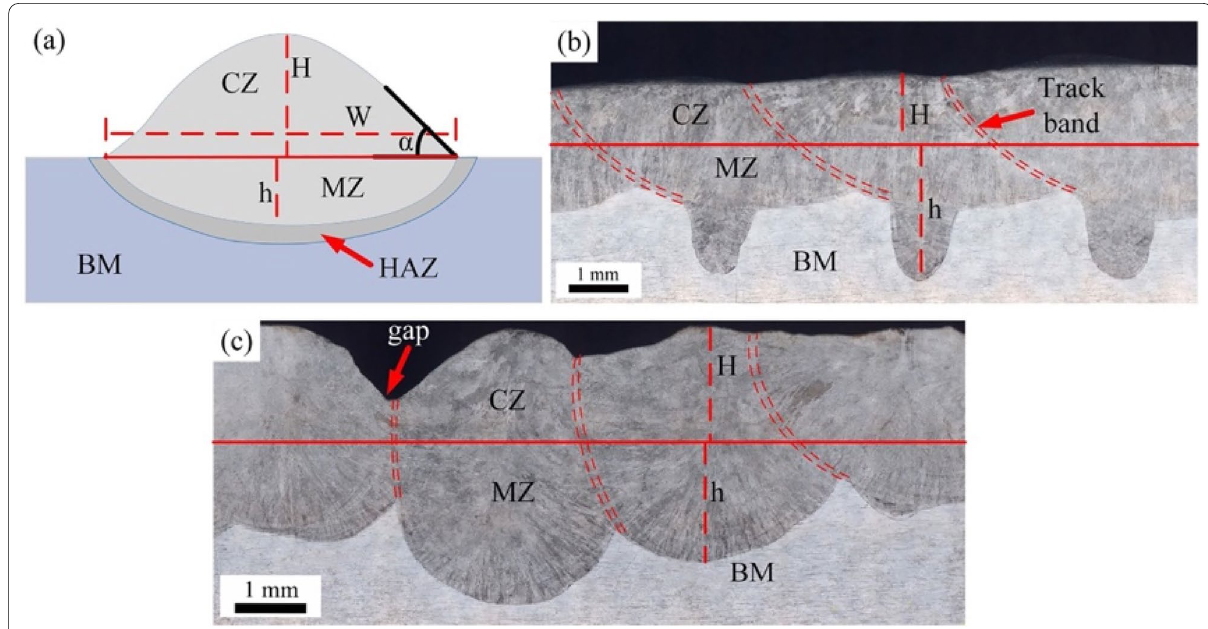
Figure 14 The macro-morphology of the transverse section: ( a ) diagram, ( b ) in-air laser cladding coating, ( c ) underwater laser cladding coating of 304 stainless steel [44]